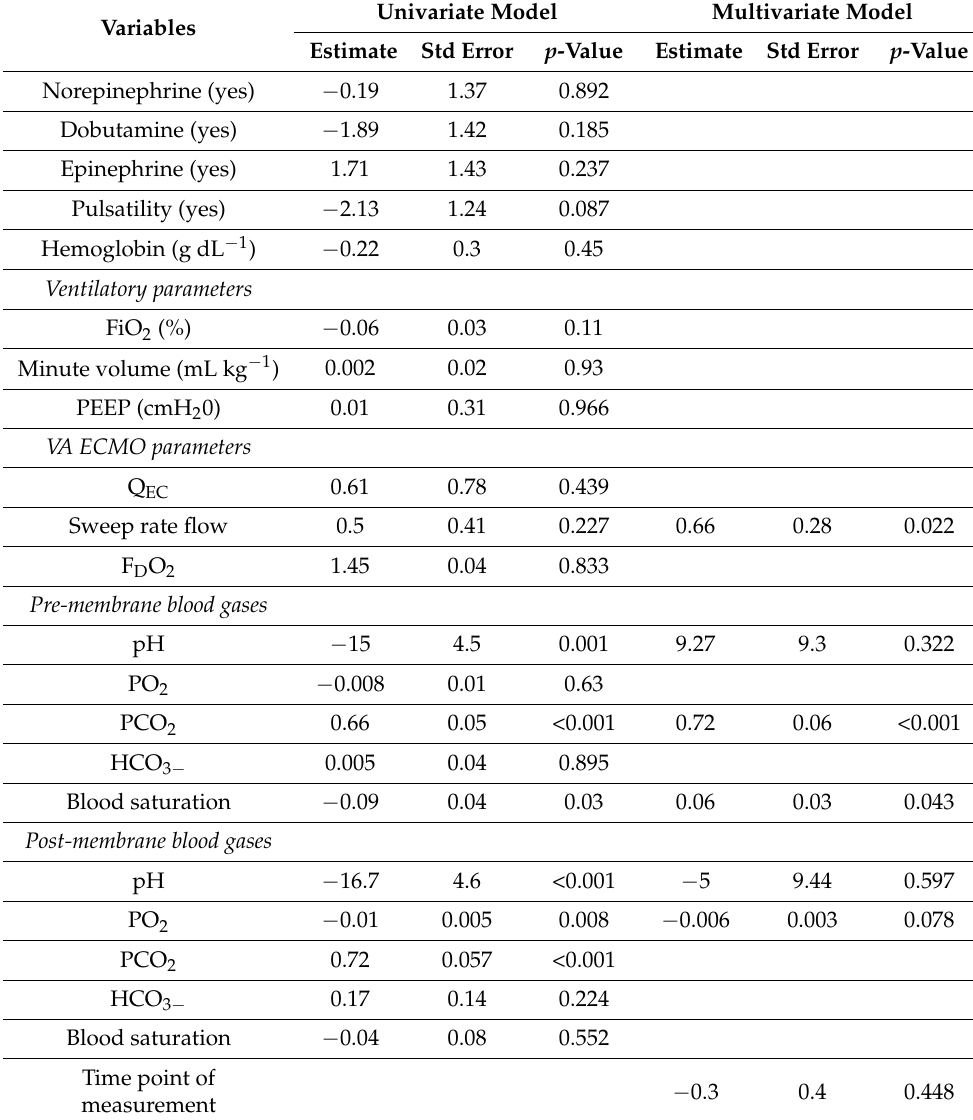
Table 3. Mixed generalized linear model with random “subject” for longitudinal analysis of the variables associated with right radial artery PaCO 2 . A univariate analysis was followed by a multi- variate